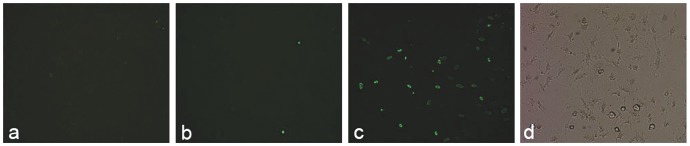
Incubation with CSO-SA/PEDF (24 µl/ml) induced fluorescent TUNEL-positive changes in ECSC nuclei after 48 h and 72 h of treatment.It shows that apoptotic cells in ECSC (d) increases significantly after 48 h (b) and 72 h (c) of treatment comapred to controls (a). (original magnification ×200).